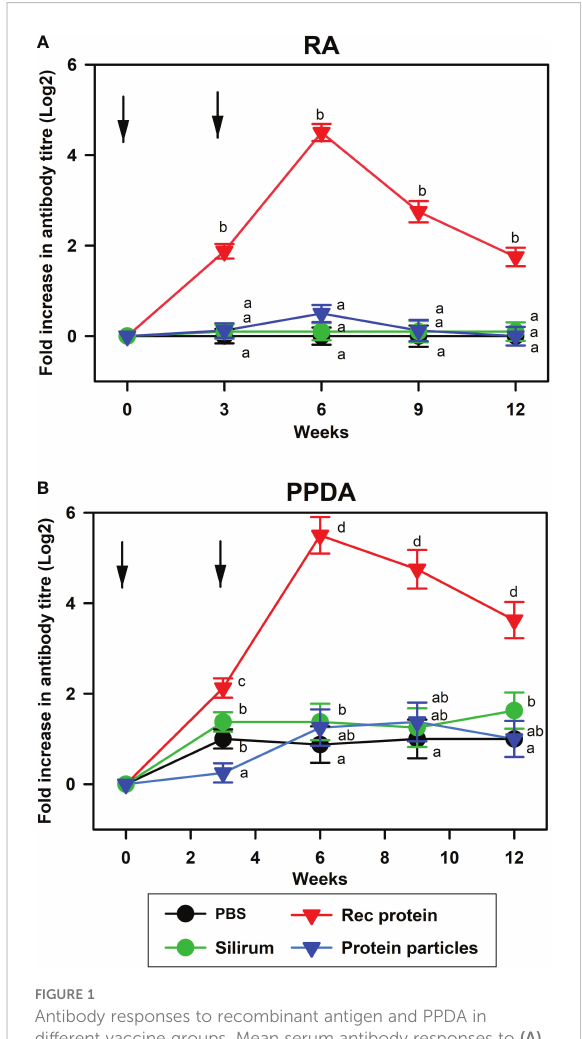
FIGURE 1 Antibody responses to recombinant antigen and PPDA in different vaccine groups. Mean serum antibody responses to (A) , recombinant antigen (RA); and (B) , PPDA in calves vaccinated with PBS, Silirum ® , rMAP fusion protein (Rec protein) and protein particles displaying MAP fusion protein (Protein particles) vaccines at weeks 0 and 3. Timing of vaccinations is indicated by arrows. Antibody titers were measured in sera before vaccination and after vaccination at weeks 3, 6, 9, and 12 using ELISA. Signi fi cance differences (P < 0.05) in antibody responses between different vaccine groups are indicated by different letters, while the same letter indicates no signi fi cant